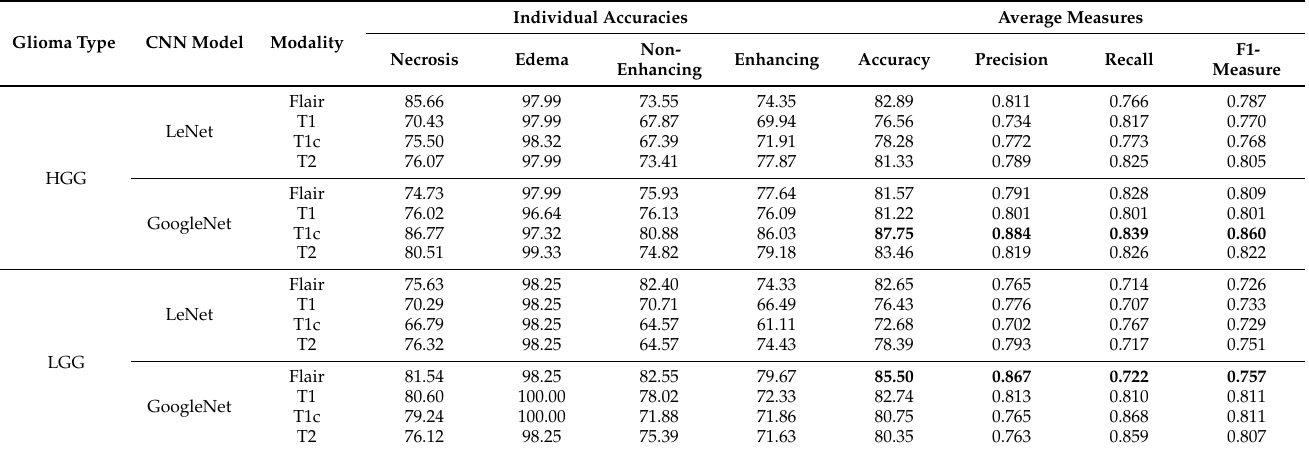
Table 2. Multiclass Glioma Tumor using other well-known CNN models (GoogleNet and LeNet) for brain MR